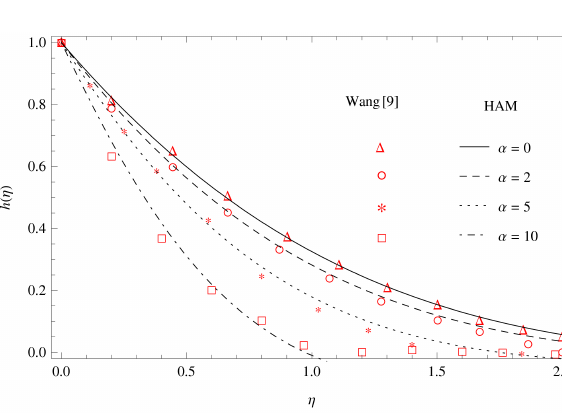
Fig. 29: Comparison of velocity profile h for Wang [9] and HAM solu- tion